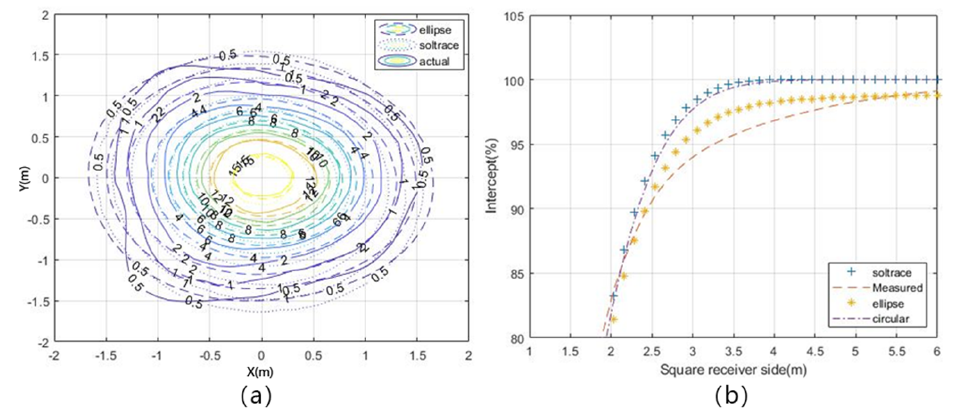
Figure 10. ( a ) Contours of the measured and computed flux distribution (kW/m 2 ): Heliostat #4, ( b ) measured and computed intercepts vs. the side length of a square receiver: Heliostat #4 .